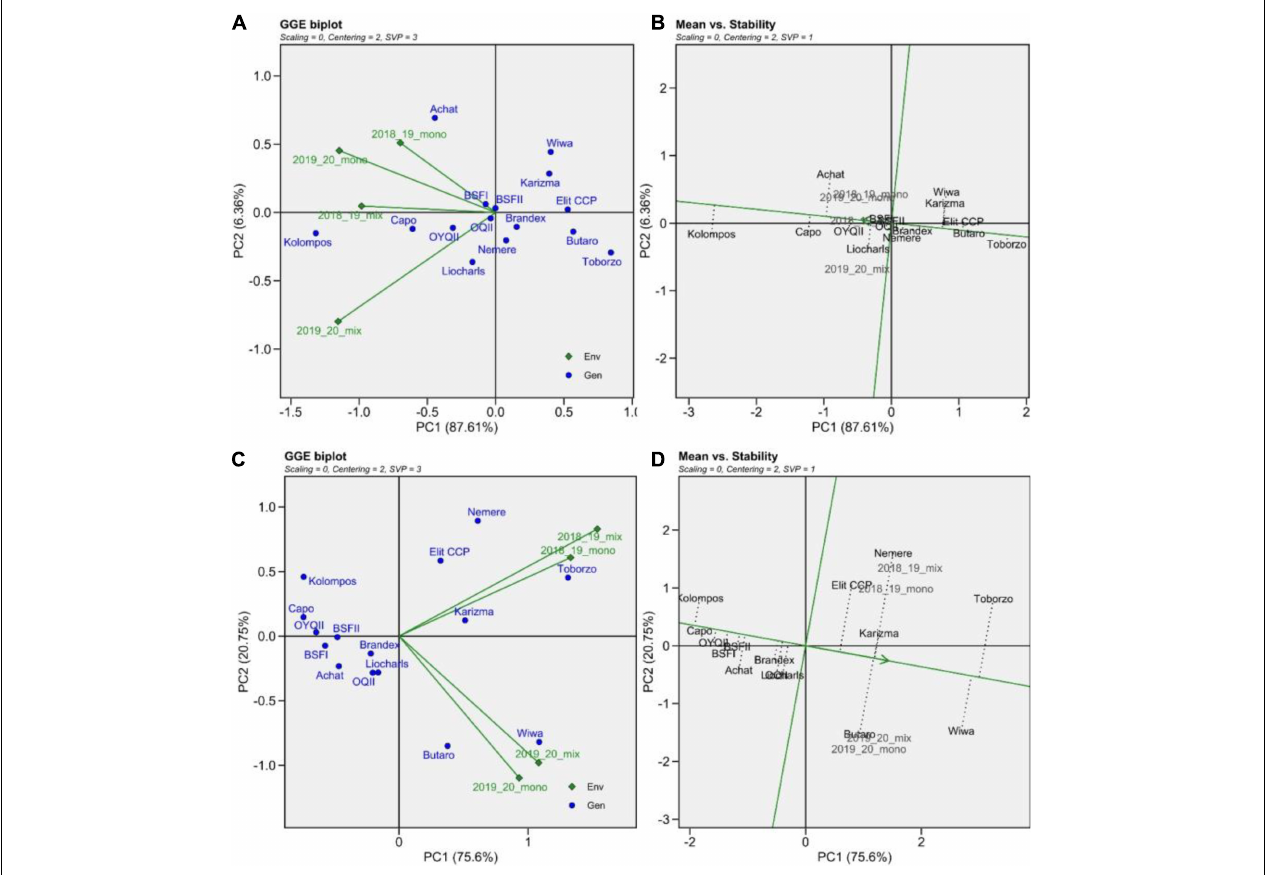
FIGURE 6 | GGE biplots for wheat (A) yield and (B) stability and protein (C) content and (D) stability across seasons 2018/19 and 2019/20 seasons. For the symmetrical (SVP = 3) GGE biplot entries are indicated in blue and environments in green. For the mean vs. stability biplot, entries are black and environments are